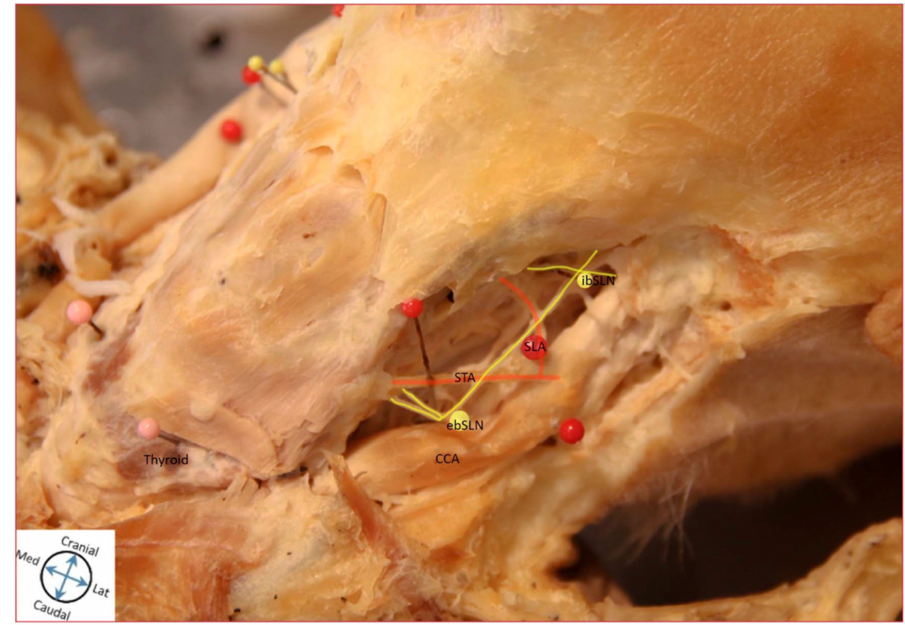
Figure 3. Cadaveric Representation of Anatomical Relationships. Cadaveric Image Representing Anatomical Relationship of External Laryngeal Nerve (ebSLN) and the Superior Thyroid Artery (STA) and Internal Laryngeal Nerve (ibSLN) with the Superior Laryngeal Artery (SLA). The image shows a unique course of the ebSLN in which it travels anterior to the STA and inserts posteriorly. The ibSLN is related superoposterior relative to the SLA. Abbreviations: ebSLN, external laryngeal nerve; ibSLN, internal laryngeal nerve; CCA, common carotid artery; ECA, external carotid artery; STA, superior thyroid artery; SLA, superior laryngeal artery.